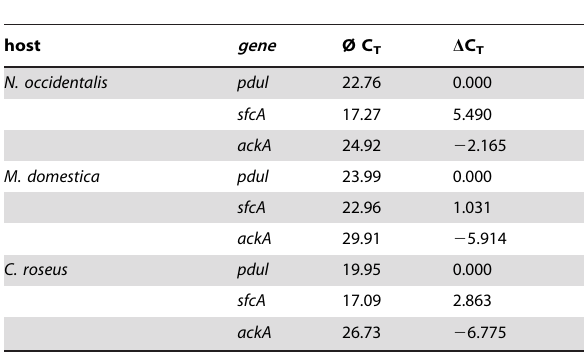
Table 4. Experimental hosts and genes used in qRT-PCR experiments with their correlating average (Ø) C T and D C T values after normalization (short